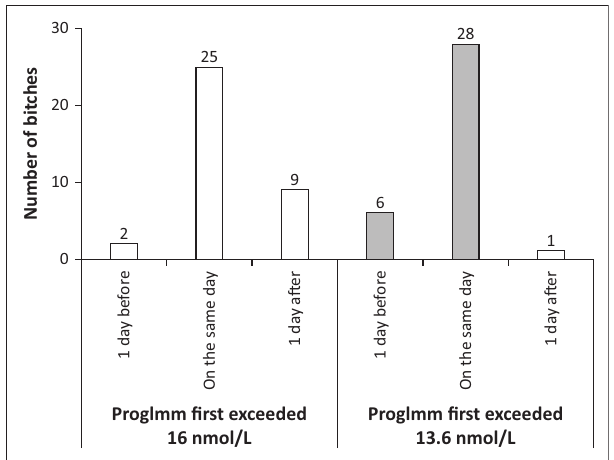
FIGURE 2: Days – relative to the day on which the concentration of progesterone measured with Coat-A-Count® radioimmunoassay in the plasma of bitches first exceeded 16 nmol/L – on which the concentration measured in their serum with Immulite® 1000 LKPW1 (ProgImm) first exceeded 16 nmol/L or its predicted value of 13.6